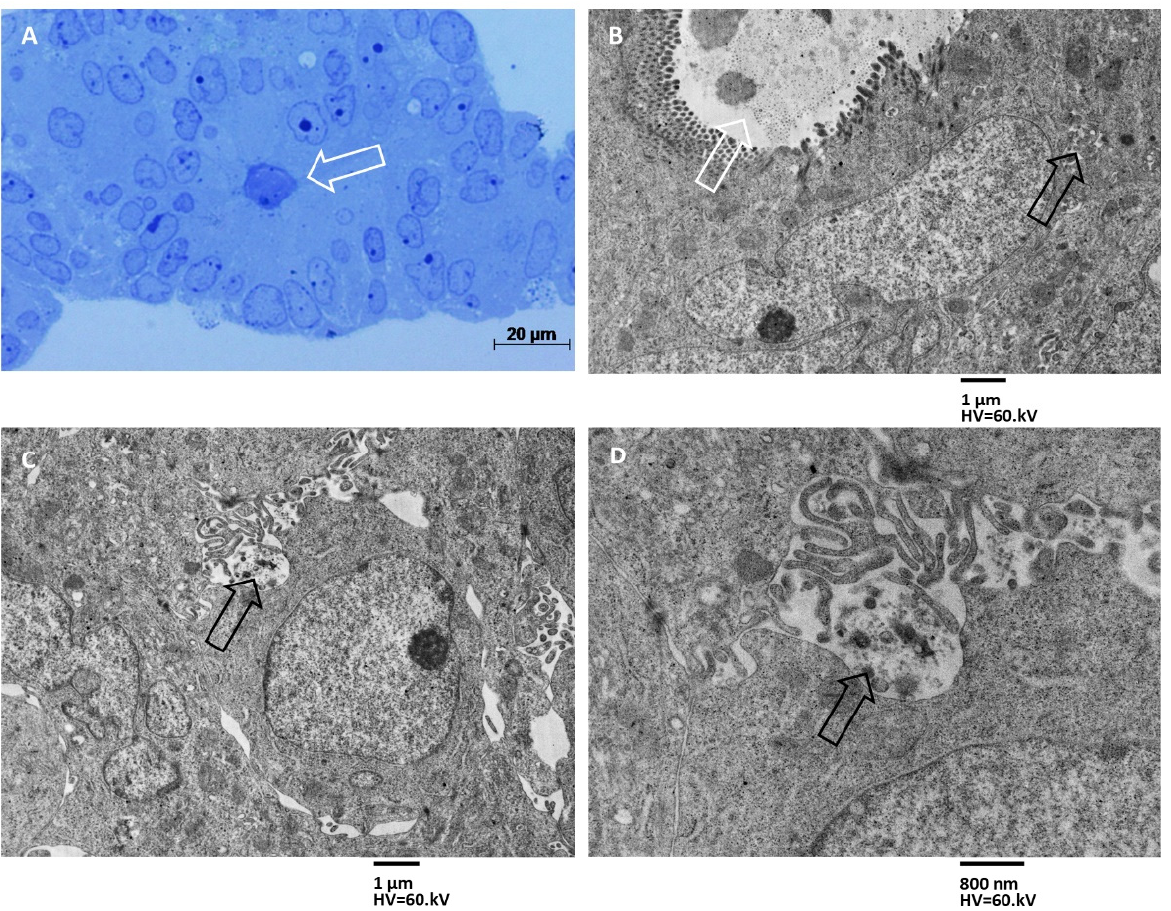
Figure 4. MTSs of group C. ( A ) Light microscopy image of a multilayered spheroid containing a pseudocyst-like structure, the lumen is indicated with a white arrow. Magnification 400×, bar 20 µm. ( B ) Cells lining the pseudocyst lumen had microvilli on the apical surface and secreted a large number of exosomes (white arrow). Cells are tightly adherent in their apical region, while in the basolateral domain, some intercellular spaces (black arrow) are visible. Magnification 1600×, bar 1 µm. ( C ) Cells in the outermost layers are separated by rare and narrow intercellular spaces, in which finger-like eversions of cell membranes project (black arrow). Magnification 1600×, bar 1 µm. ( D ) Secretion of exosomes was observed from the middle layers of cells’ membrane, which spill exo- somes into the intercellular spaces (black arrow). No exosome secretion was observed from the outermost cell layers towards the external surface of the spheroid. Magnification 4000×, bar 800 nm.